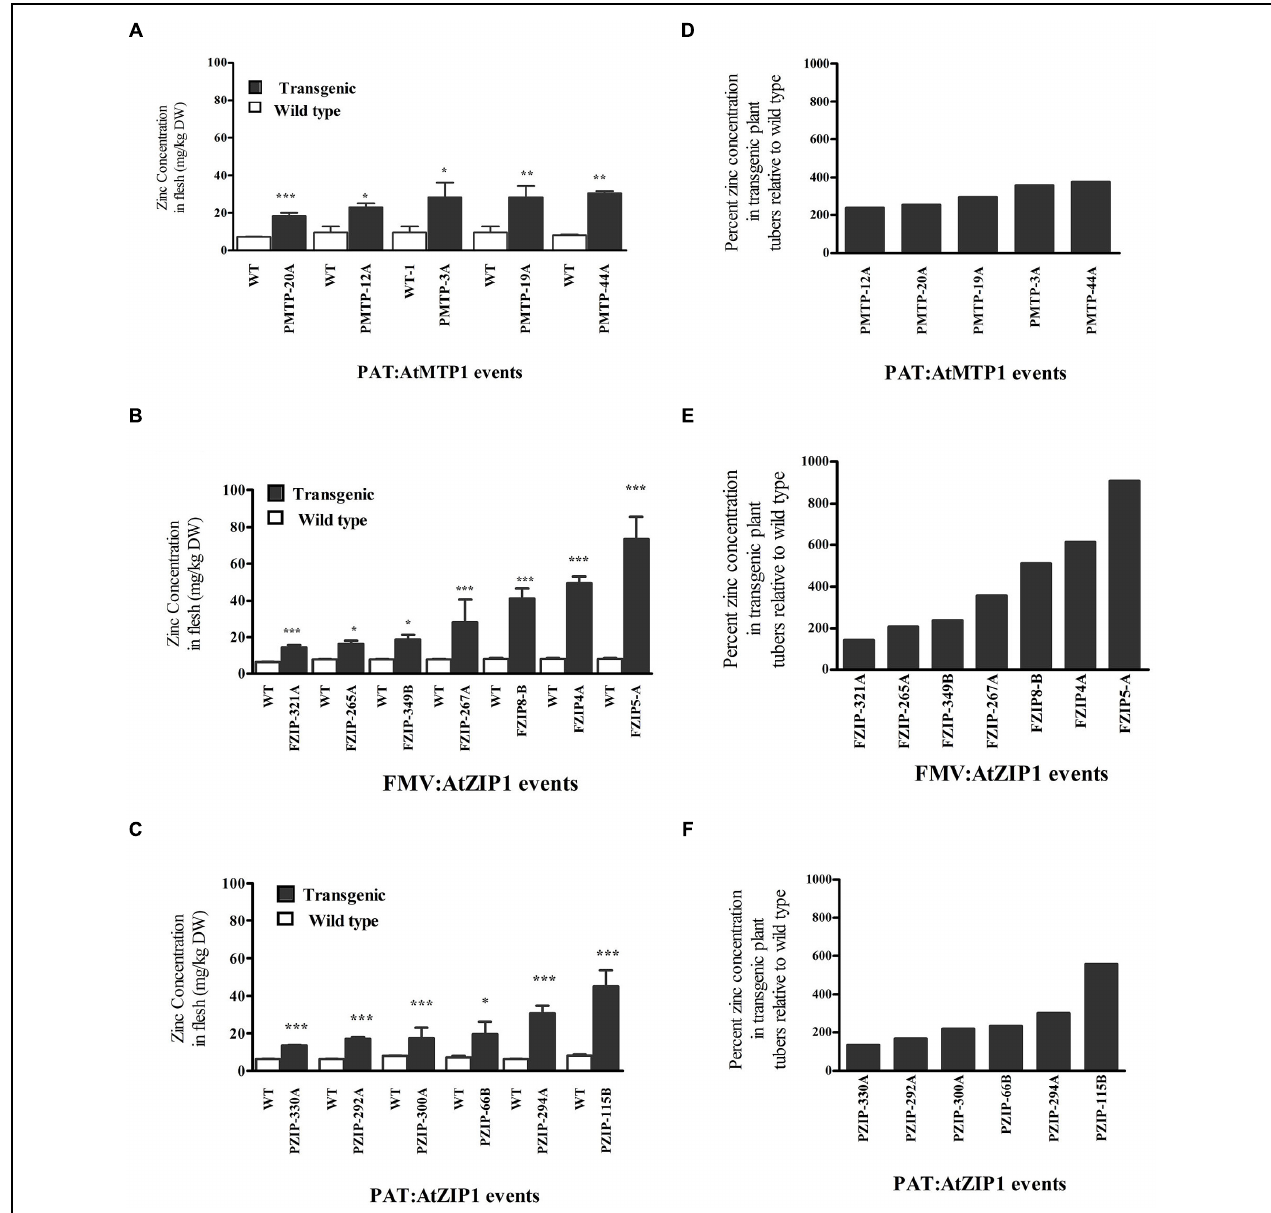
FIGURE 1 | Zinc concentration (A–C) and percentage increase in zinc concentration with respect to wild type (D–F) in 4-months-old cassava transgenic storage roots from growth chamber grown plants. Values are mean zinc content normalized for dry weight (DW) of three independent